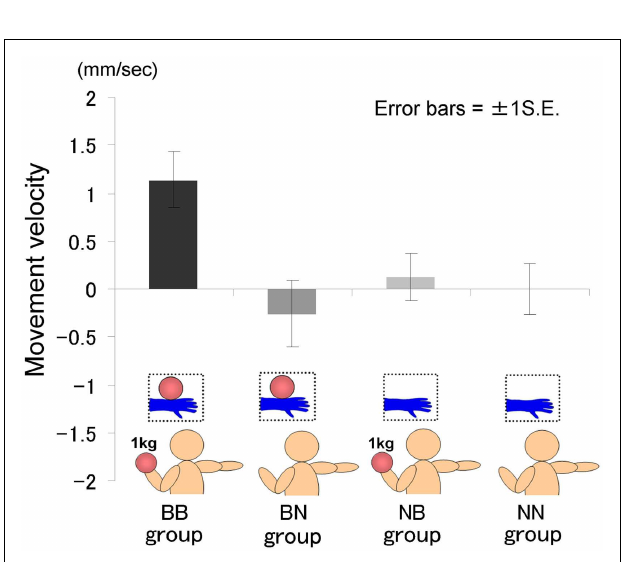
FIGURE 3 | Movement velocity in each group in Experiment